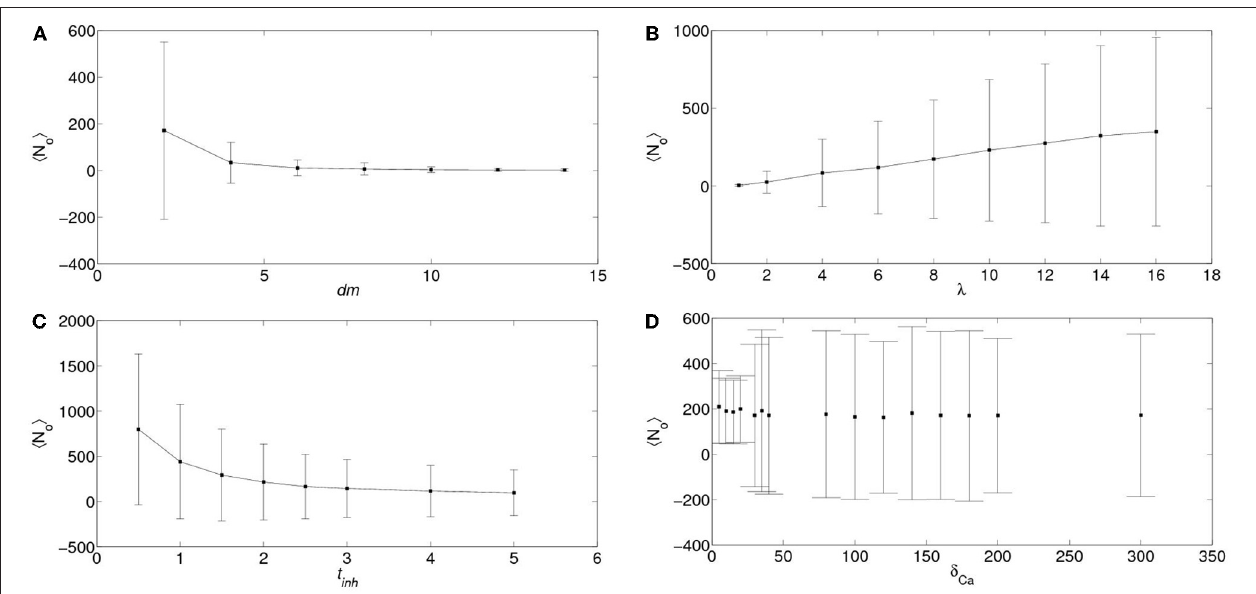
FIGURE 8 | Dependence of the number of IP 3 R’s that participate of a signal on various parameters. Mean (symbols) and standard deviations (vertical lines around mean) of the number of IP 3 R’s that participate of a signal, N o , as a function of the inter-cluster distance, dm ( A ), of the